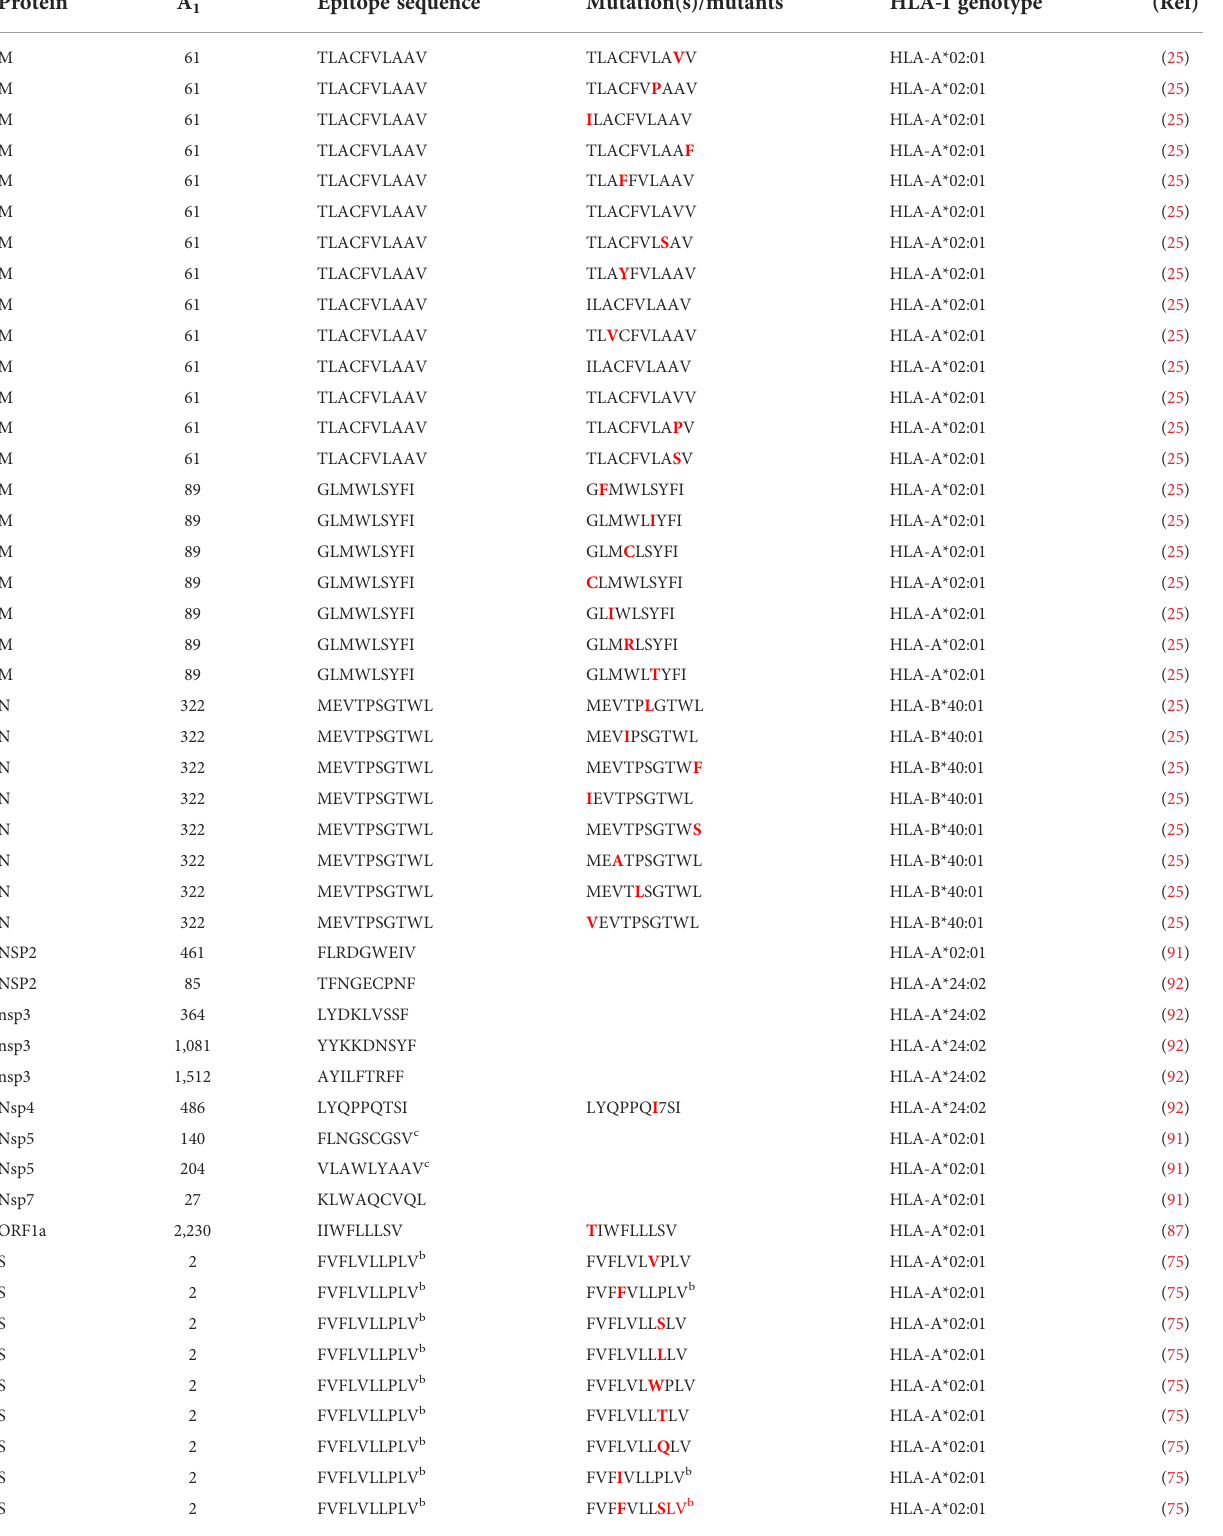
TABLE 2 Dominant and strictly validated non-conserved CD8 + T-cell – activating epitopes of SARS-CoV-2 involved in VOC immune escape.